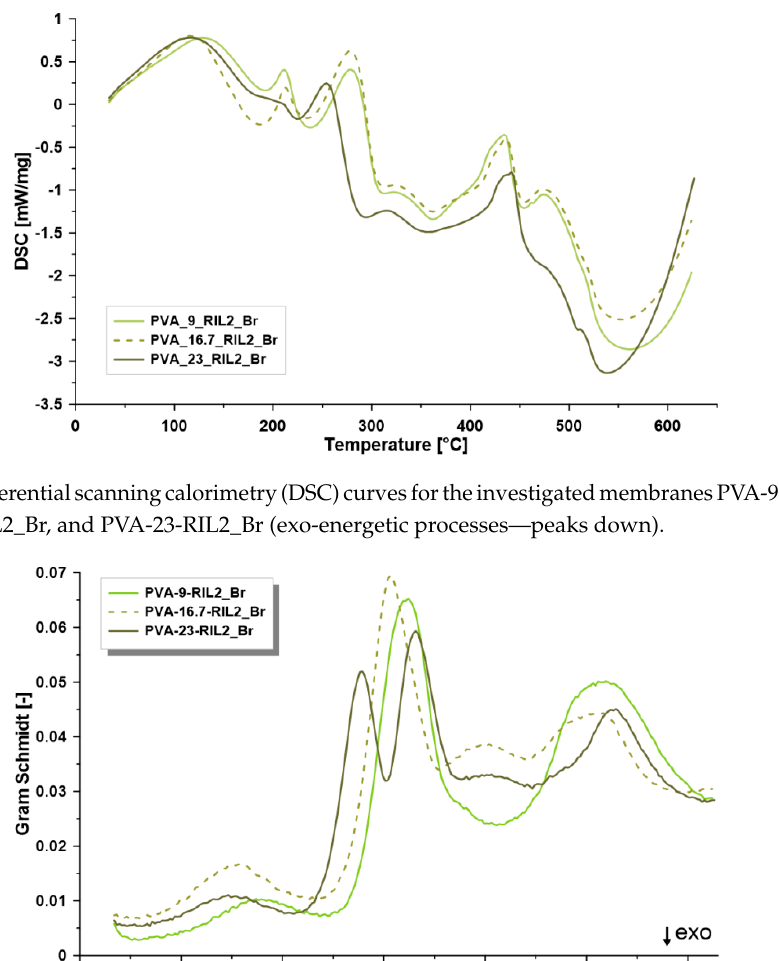
Figure 7. Differential scanning calorimetry (DSC) curves for the investigated membranes PVA-9- RIL2_Br, PVA-16.7-RIL2_Br, and PVA-23-RIL2_Br (exo-energetic processes—peaks down).